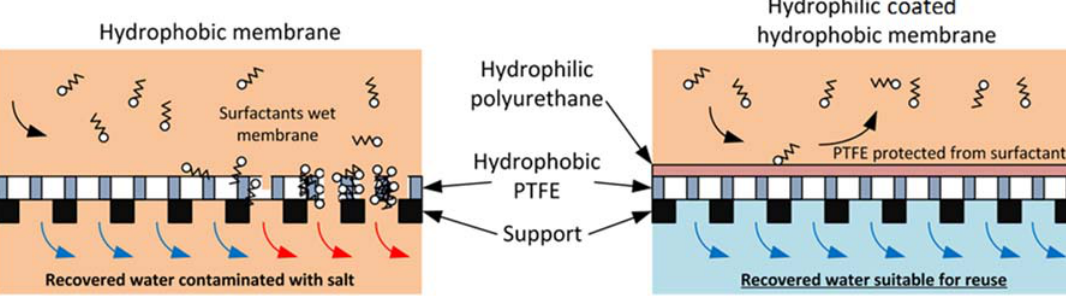
Figure 10. Figure explaining wetting on both membranes.